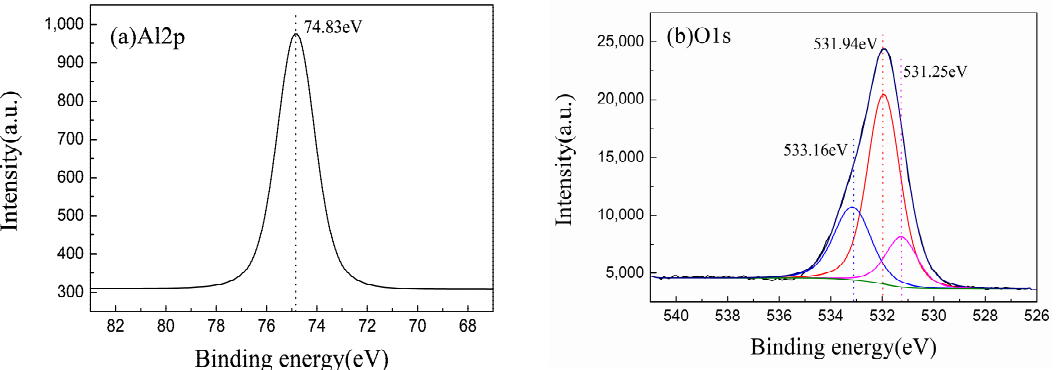
Figure 15. XPS spectrum of Kapton / Al 2 O 3 surface nanocomposite film: ( a ) Al2 p . high-resolution spectrum; ( b ) O1 s high-resolution spectrum.